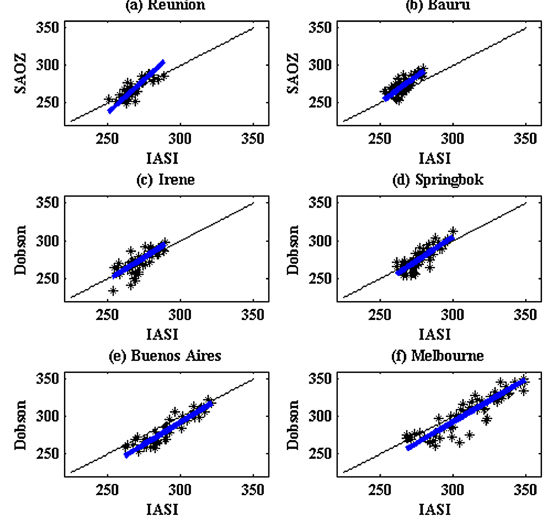
Figure 3. Scatter plot between IASI, Dobson at four sites (Irene, Springbok, Melbourne and Buenos Aires) and SAOZ at two sites (Réunion and Bauru). The black line represents the zero bias line, while the bold blue line represents the median regression line be- tween the two